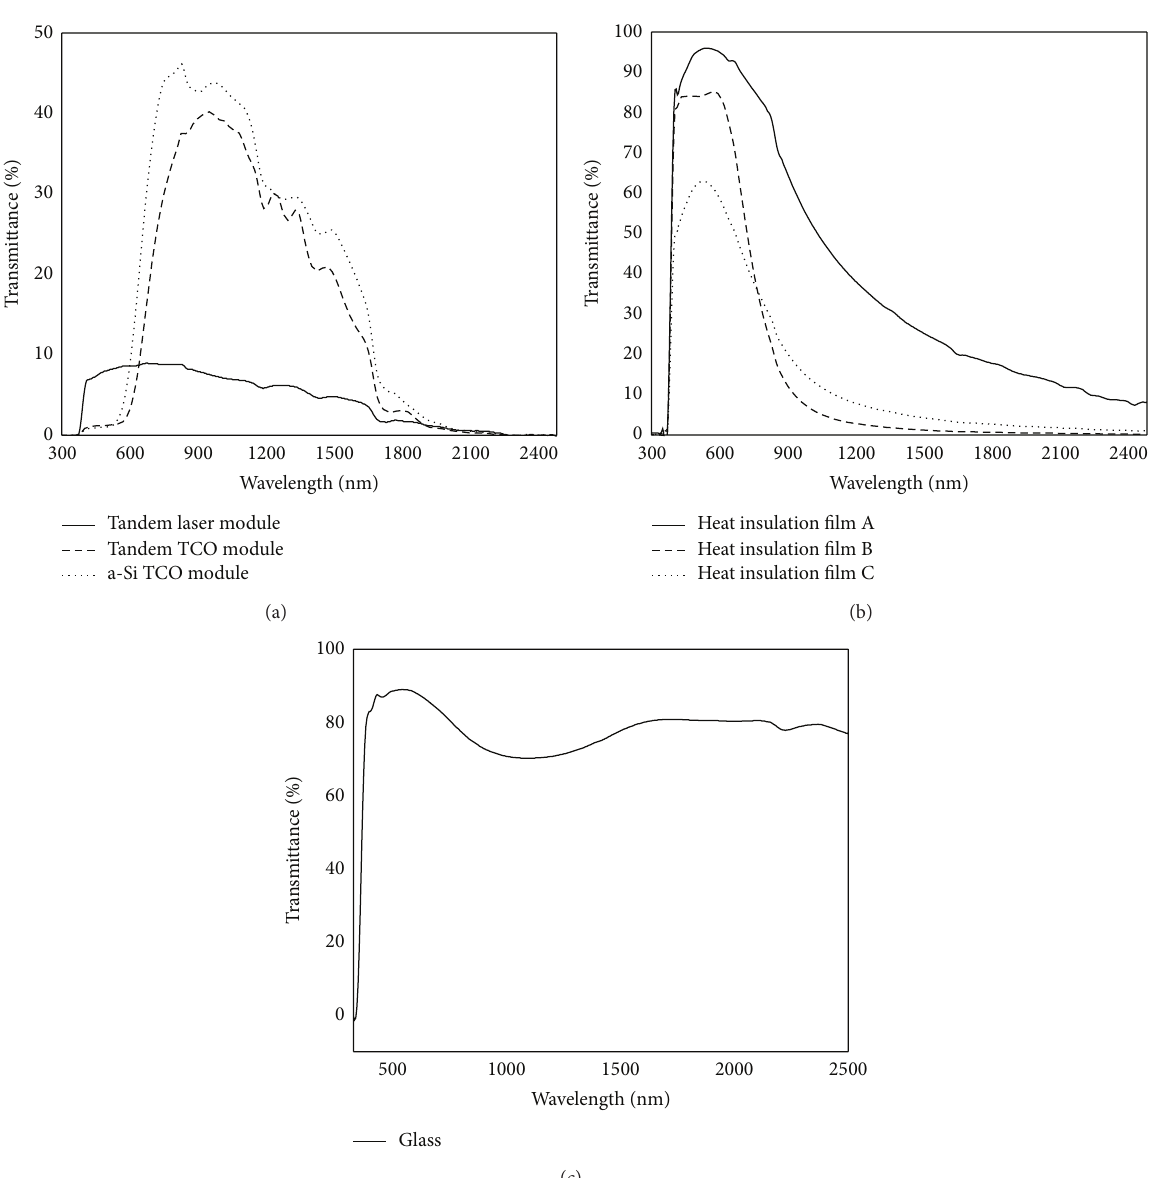
and 23.49%, but after being encapsulated into the HISG it dropped to 2.08–4.07%, 5.16–10.34%, and 6.62–13.26%, respectively. The visible light transmittance was originally 8.4%, 2.2%, and 4.35%, but after being encapsulated into the HISG it dropped to 4.78–7.23%, 1.23–1.88%, and 2.43–3.72%,